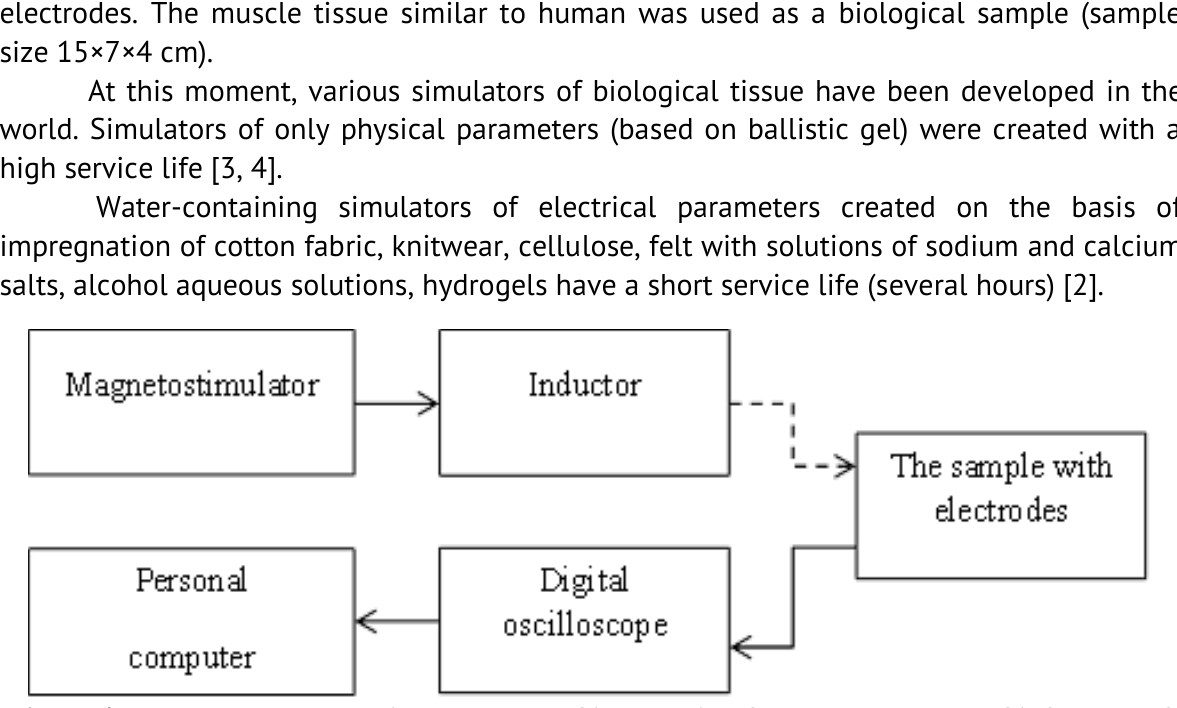
Figure 1. The structural combined scheme of installation for measurements of influence of a pulsed magnetic field on samples .